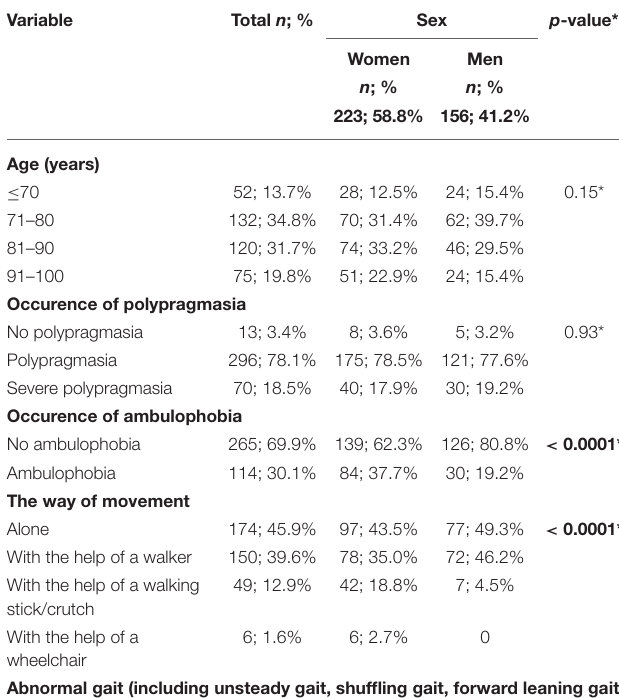
TABLE 1 | Characteristics of the study group (including gender division).